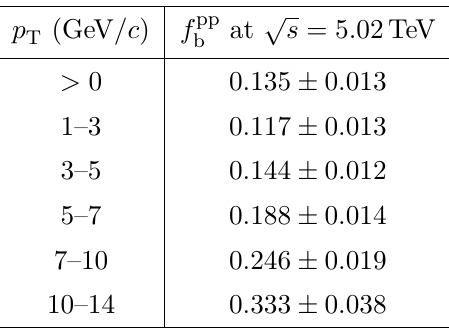
Table 3 . Fraction of non-prompt J /ψ in pp collisions at transverse momentum intervals. The reported values and uncertainties are derived following the interpolation procedure detailed in the text and in ref. [87].